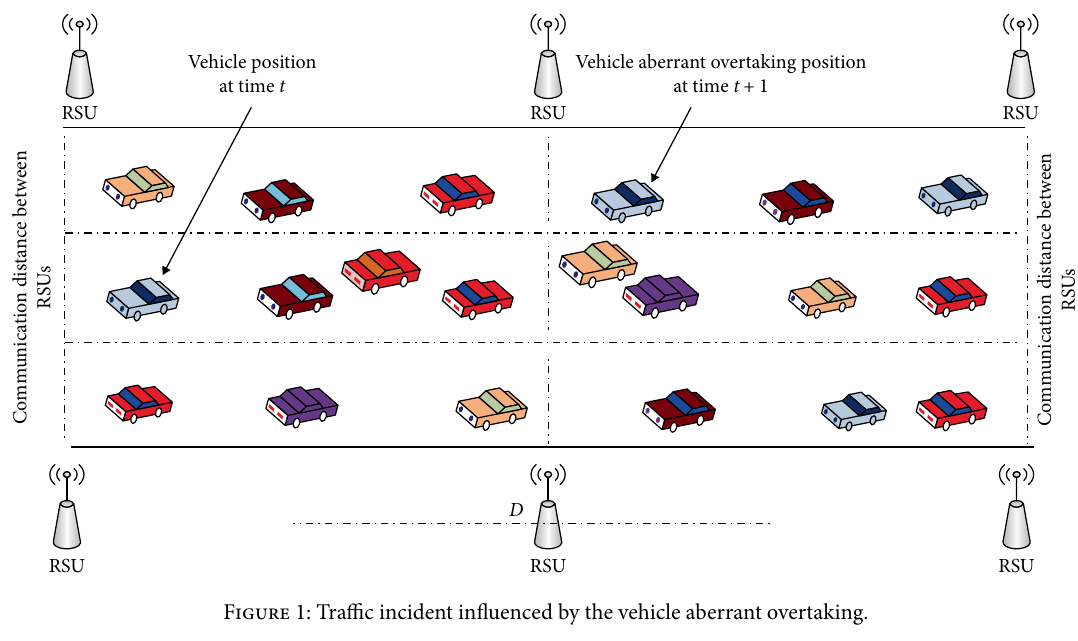
Figure 1: Traffic incident influenced by the vehicle aberrant overtaking.